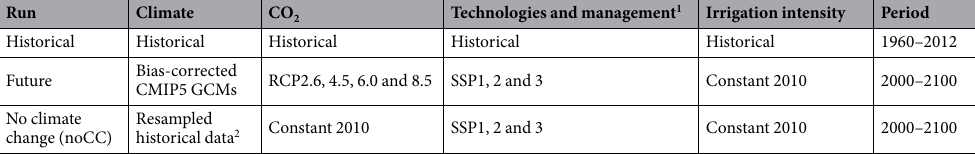
Table 1. Crop model simulations conducted in this study. 1 This includes the N application rate and knowledge stock. Agronomic adjustments are considered for all runs. 2 Climate data were randomly resampled from historical data for 1981–2010 to represent climate trends for the period. Five ensemble members were